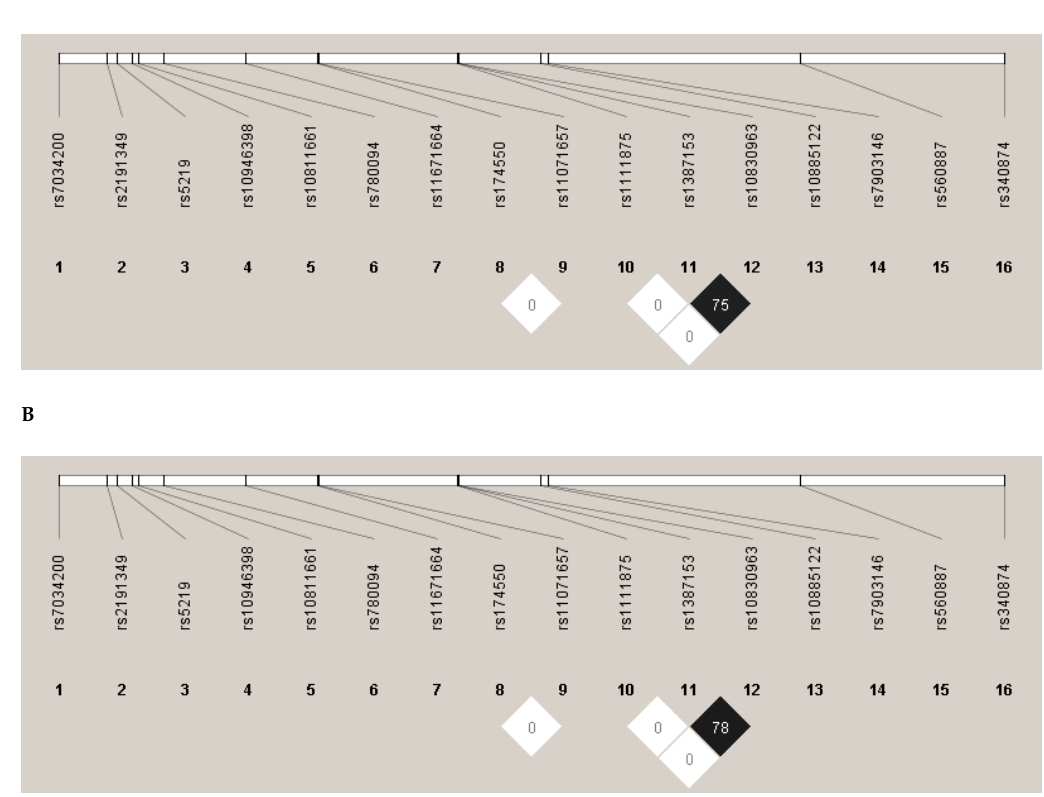
Figure 1. Linkage disequilibrium (LD) map of SNPs related to prediabetes/type 2 diabetes mellitus (T2DM) for the Hungarian general ( A ) and Roma ( B ) populations. Linkage analysis was performed separately in both populations, and none of the SNPs were found to be in LD. The numbers above the map show the reference SNP (rs) numbers of SNPs. Alternative coefficient of linkage disequilibrium (D’)/logarithm of odds (LOD) color scheme is used to display LD (white D’ < 1 and LOD < 2; and black D’ < 1 and LOD ≥ 2). Numbers in squares are r 2 values.